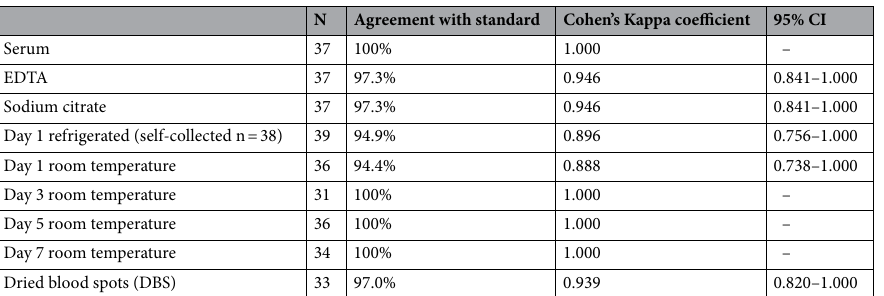
Table 2. Agreement between results of the COVID-19 IgG ELISA performed on different sample types and days post sampling, compared with a reference standard of plasma from venous blood collected in lithium heparin-treated